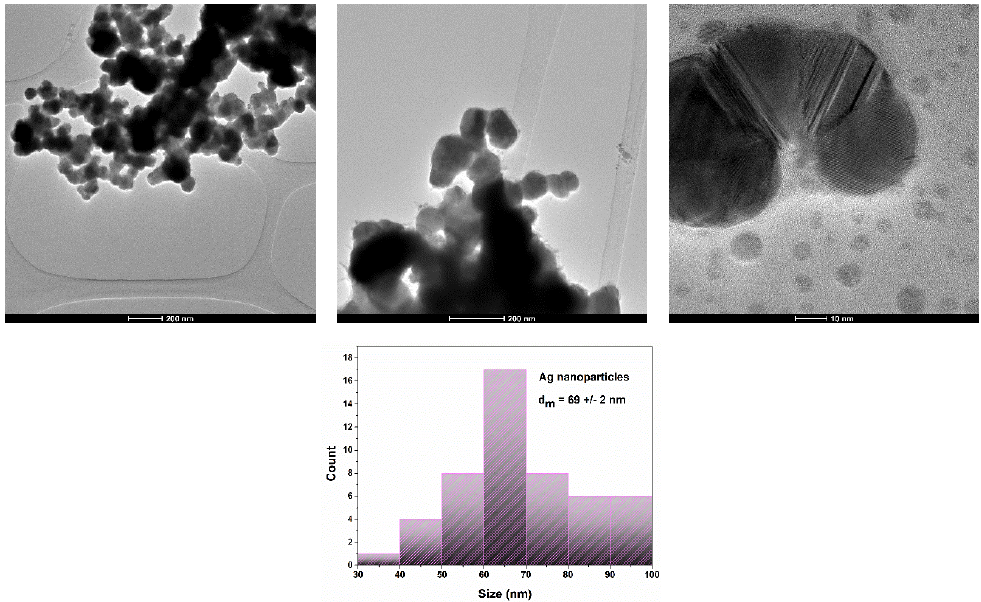
Figure 3. TEM analysis of silver nanoparticles powder.